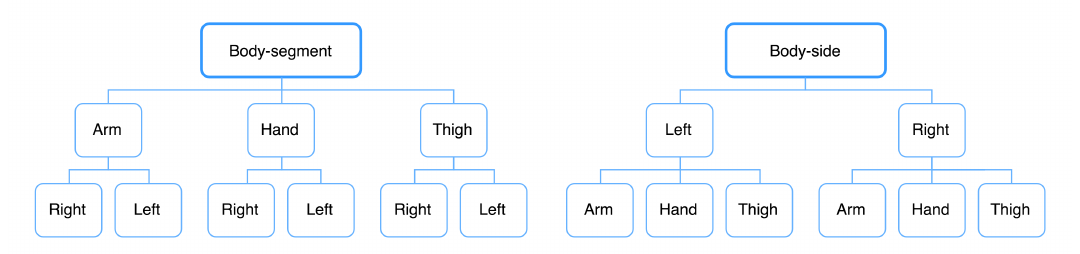
Figure 6. The hierarchical classification body-segment approach ( left ) and body-side approach ( right